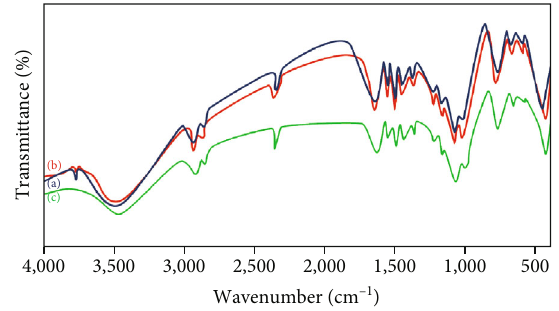
Figure 6: Infrared spectra of (a) virgin epoxy coating, (b) 5% titanium-embedded epoxy coating, and (c) 10% titanium- embedded epoxy coating after natural exposure testing at